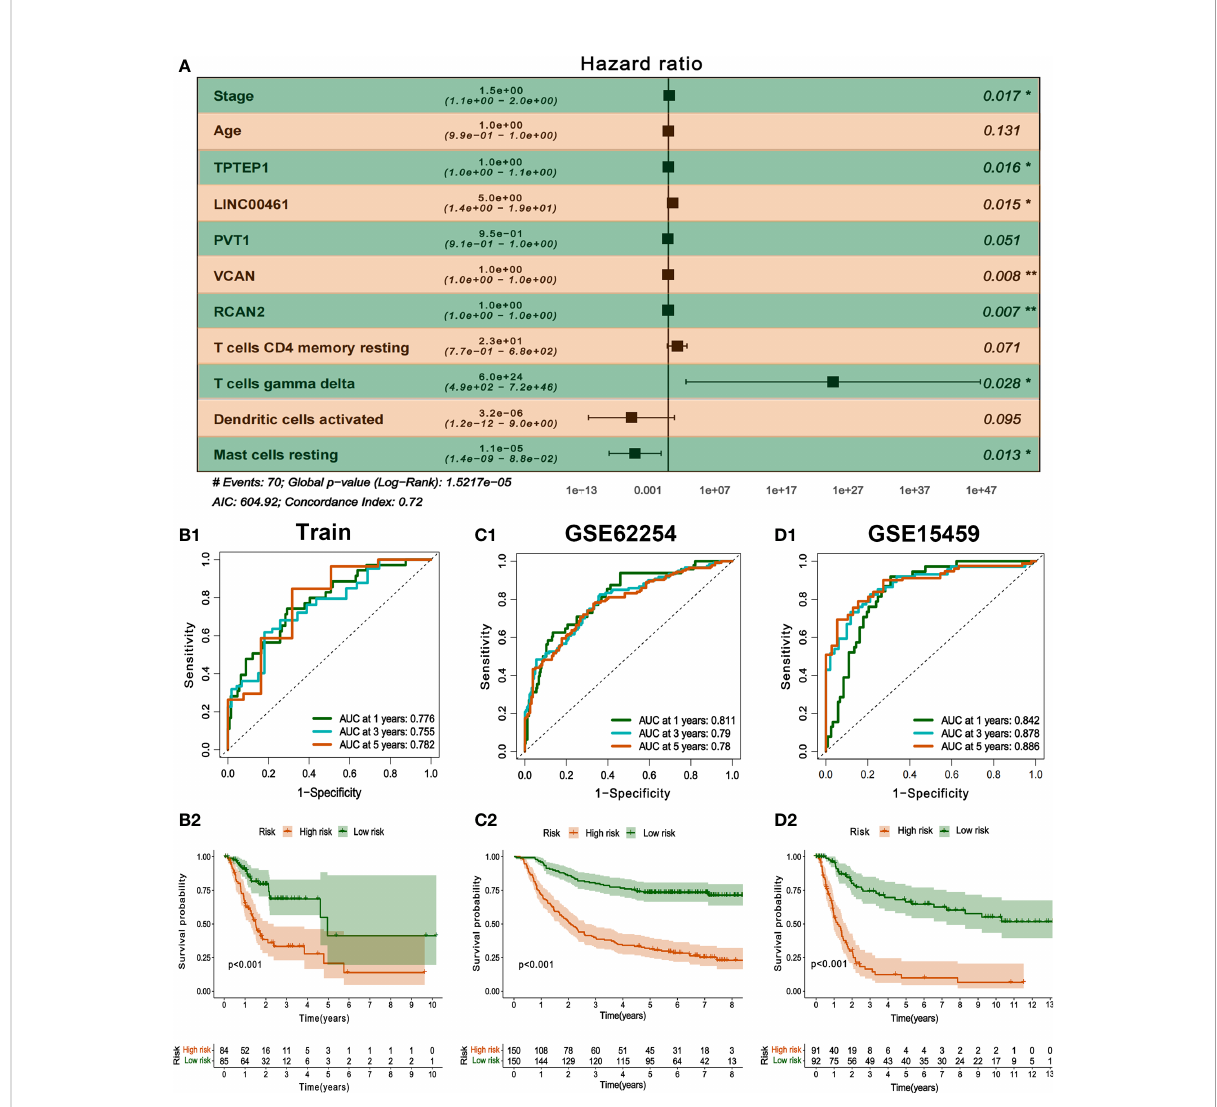
FIGURE 8 Construction and validation of comprehensive prognostic model. (A) Multivariate Cox model was used to construct a comprehensive prognosis model. (B1-2) ROC curve and K-M survival analysis of training set. (C1-2, D1-2) ROC curve and K-M survival analysis of GSE62254 and GSE15459 external validation